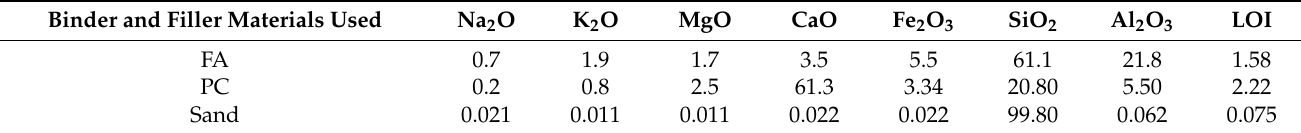
Table 1. Chemical properties of binder and filler materials (% by weight).